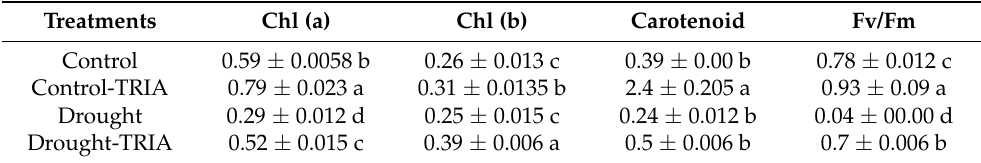
Table 3. Effects of TRIA (35 ppm) on photosynthetic pigment contents ( µ g/g FW) and the maximal photochemical efficiency of the primary photochemistry (Fv/Fm) of the leaves of rice seedlings exposed to drought stress. Data are means of three replicates ± SE.